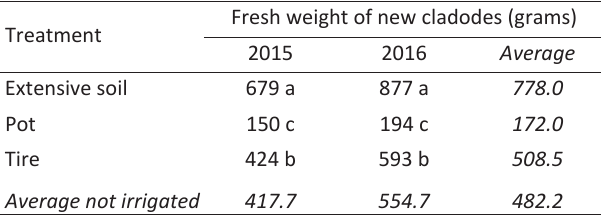
Table 2 - Fresh weight (grams) of new cladodes in the three treatments in the two years of trial and average